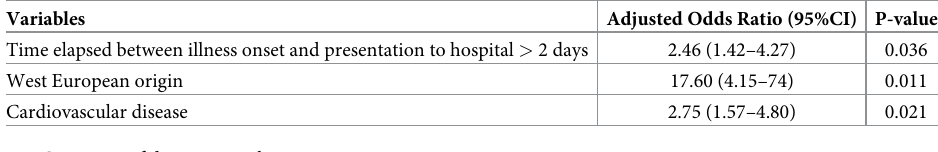
Table 2. Factors associated with severity of dengue in adults with positive RT-PCR at disease onset. Multivariate analysis using logistic regression. CARBO cohort study, Re´union Island 2019 (N =